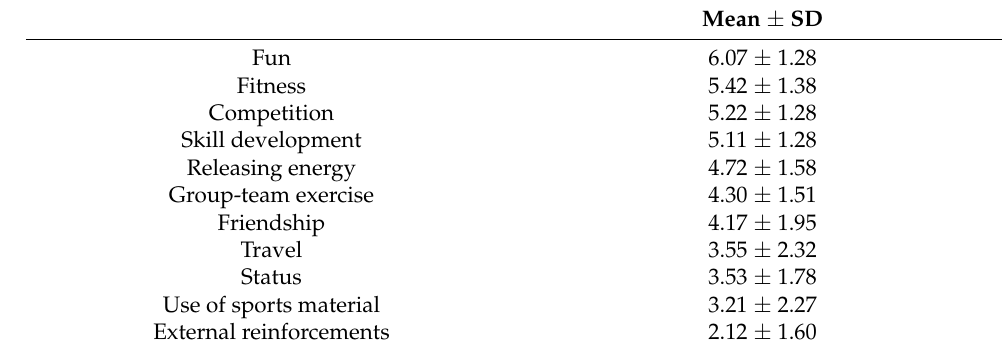
Table 2. Mean values in descending order of athletes’ reasons for playing table tennis.